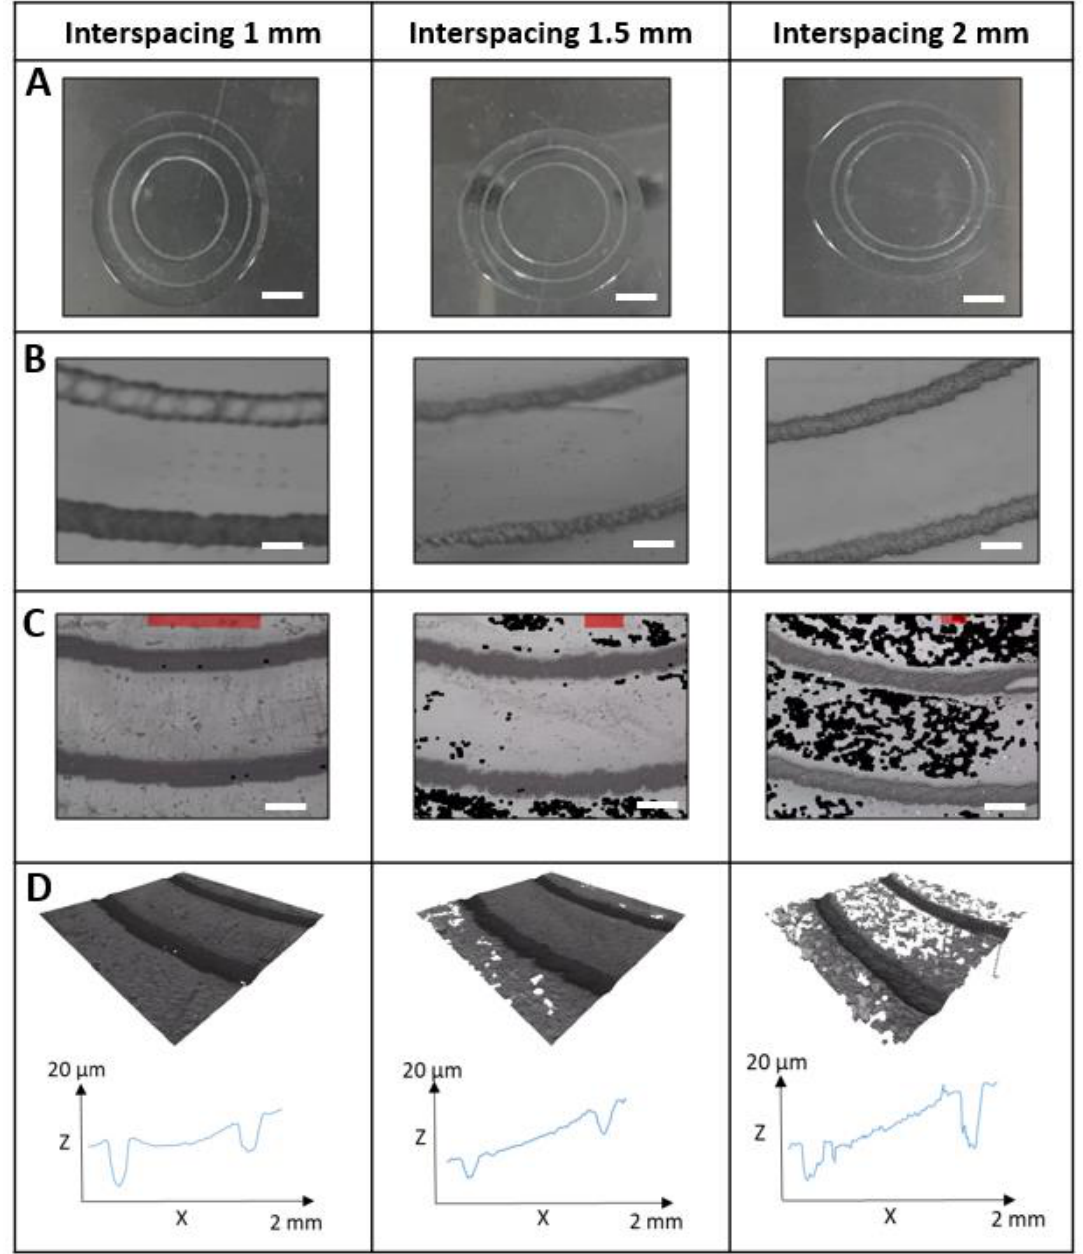
Figure 4. Pictures of the laser-treated contact lenses. ( A ) Photographs of the CO 2 laser-engraved rings on the lenses produced at laser power of 40 W and scanning speed of 440 mm · s − 1 , scale bar 3 mm; ( B , C ) Microscopic images of the laser-modified contact lenses; ( D ) 3D microscopic images of the channels and related surface profiles.